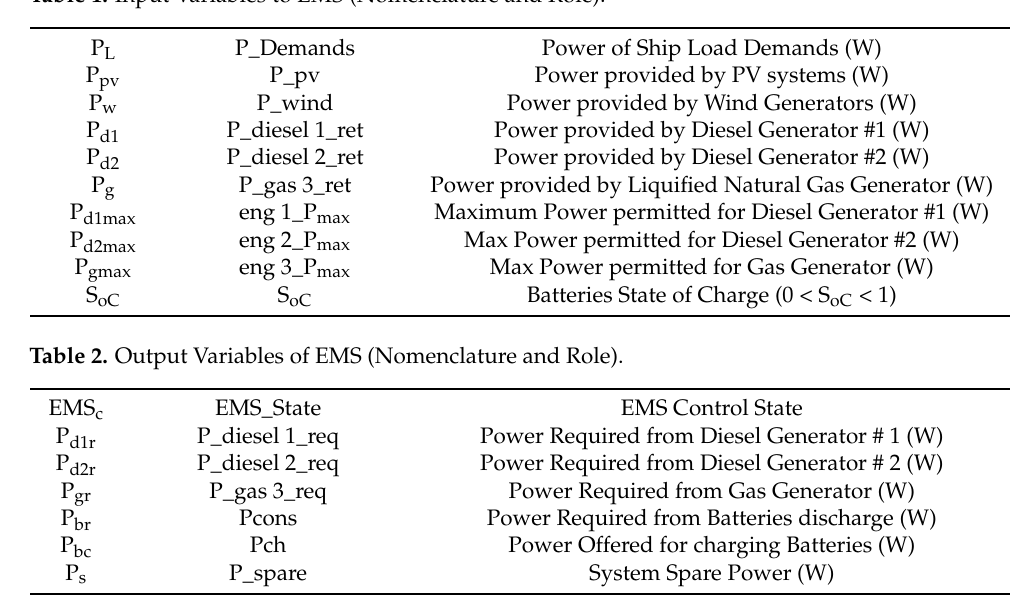
Table 1. Input Variables to EMS (Nomenclature and Role).